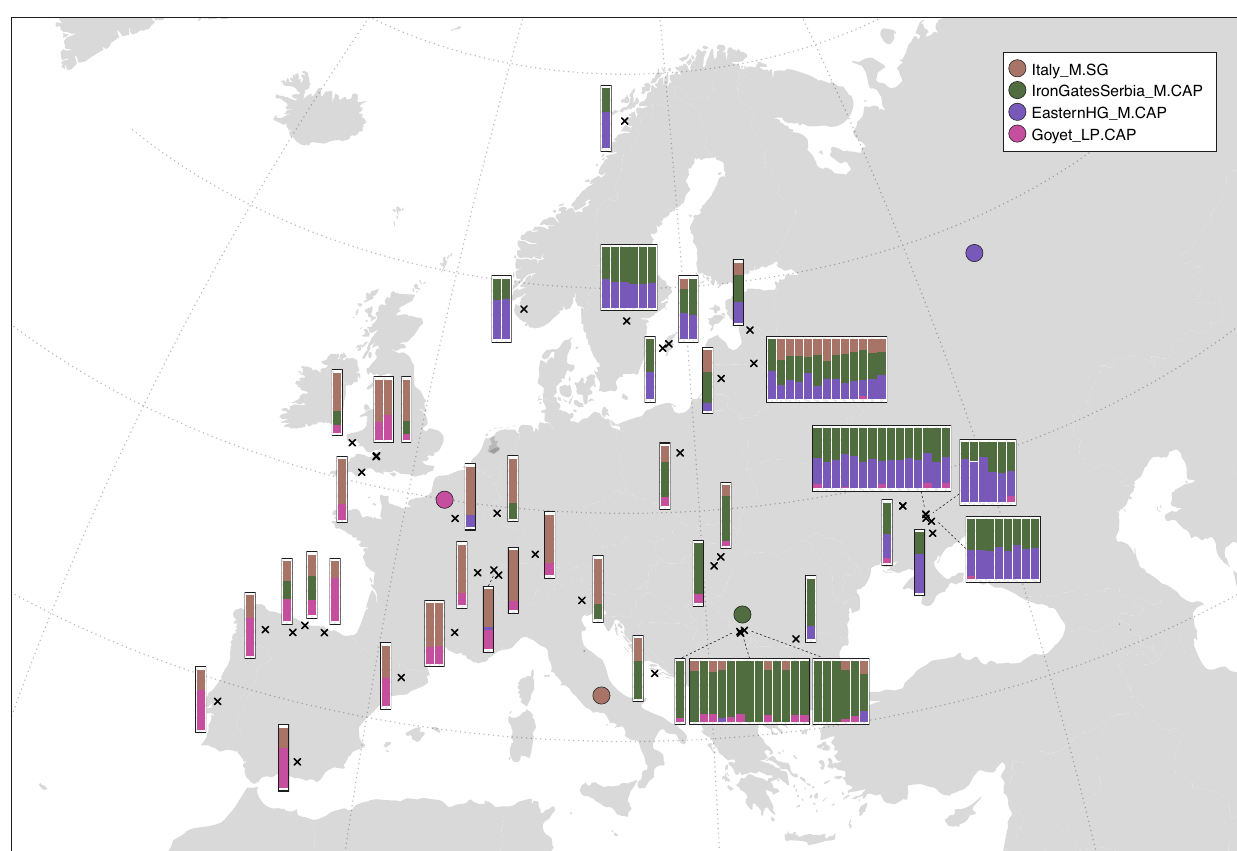
Fig. 2 Spatial distribution of hunter-gatherer ancestry clusters. Map showing geographic locations (black crosses) and ancestry proportions (bar plots) of post-LGM hunter-gatherers, inferred using qpAdm (Supplementary Data 14). Individuals were modelled using four source groups, representing major post-LGM lineages identi fi ed in this and previous studies. Approximate geographic locations of source groups are indicated with coloured